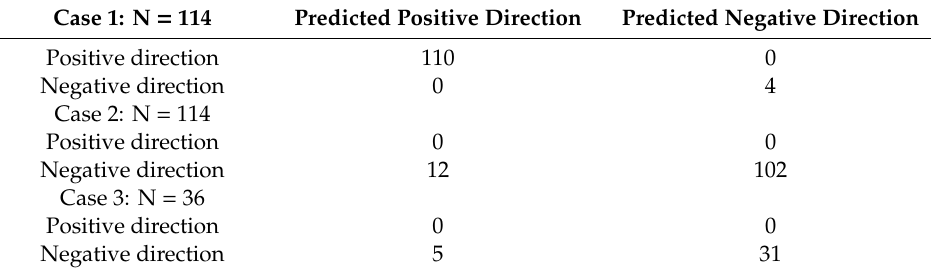
Table 2. Confusion matrix for three simulation cases (quantity of cars).